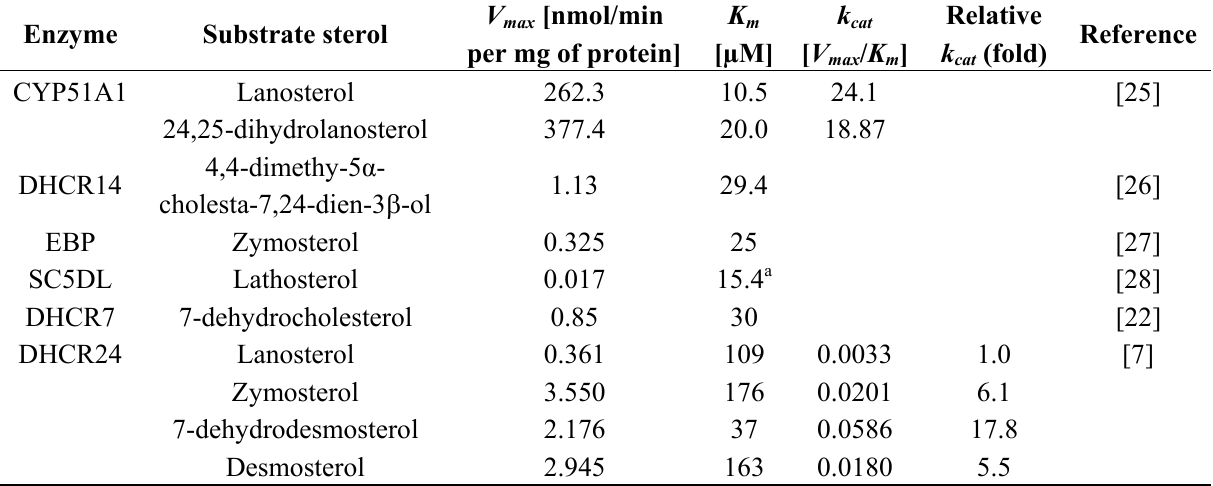
Table 4. Kinetic parameters of cholesterol synthesis enzymes with specific sterols as substrates.